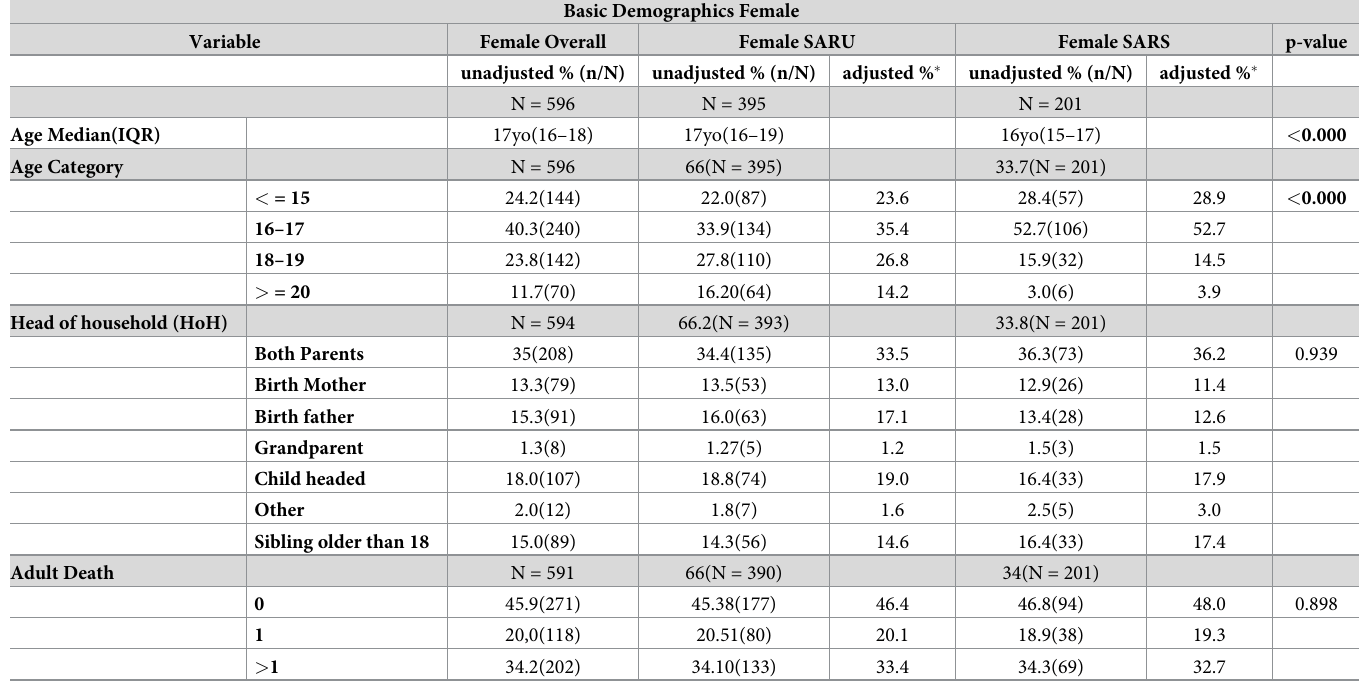
Table 1. Demographics and basic behavioural characteristics of sexually active students in rural KwaZulu-Natal, South Africa. Basic Demographics